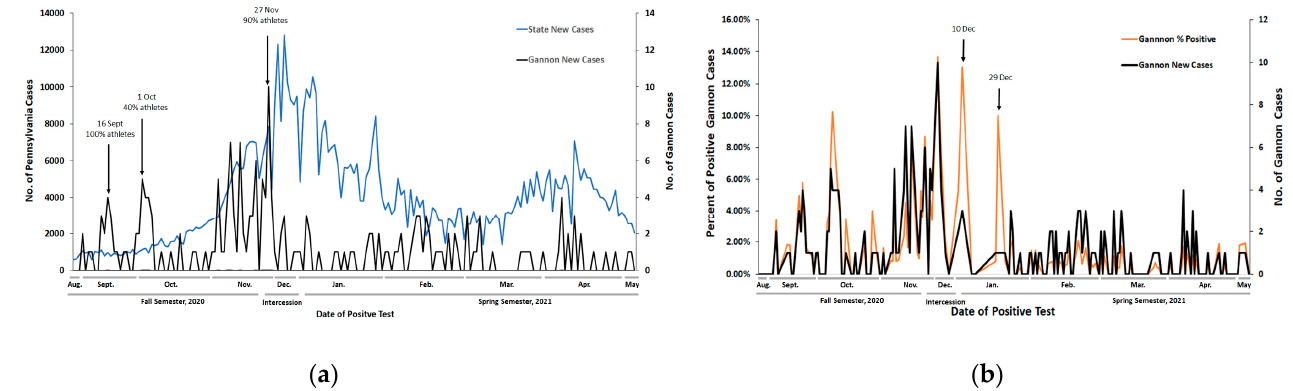
Figure 1. Temporal trends of COVID-19 infection at Gannon University and Pennsylvania, United States. Data points reflect only days between the time periods indicated that Gannon University processed samples. n = 179 total days of sampling. ( a ) Cumulative number of daily samples testing positive for COVID-19 infection between 24 August 2020–12 May 2021; ( b ) percent of samples testing positive for COVID-19 infection between 24 August 2020–12 May 2021.